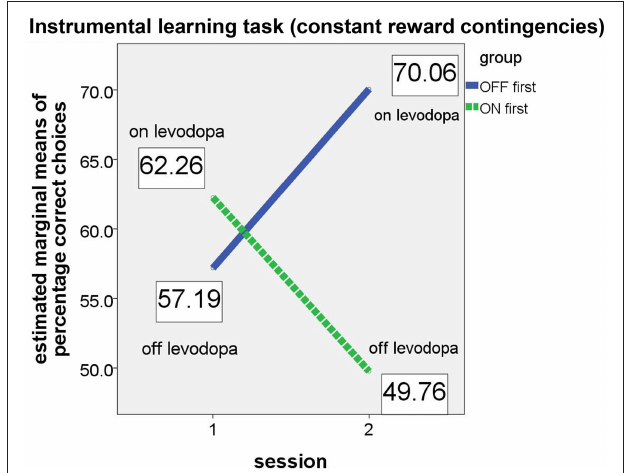
FiGure 3 | Performance of ON-beginner (“ON first”) and OFF-beginner subgroups (“OFF first”) across sessions on the instrumental learning task. Covariate-corrected estimated means of percentage of correct choices are shown in